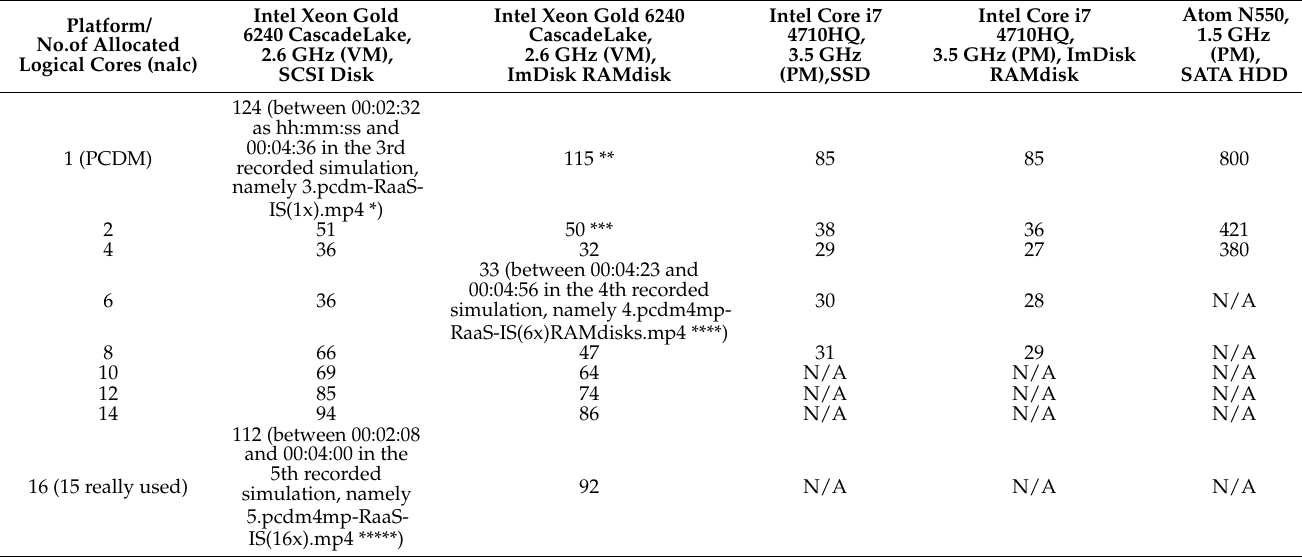
Table 1. The best execution time (approximation in sec.) of PCDM and PCDM4MP for different hardware configurations on WVS